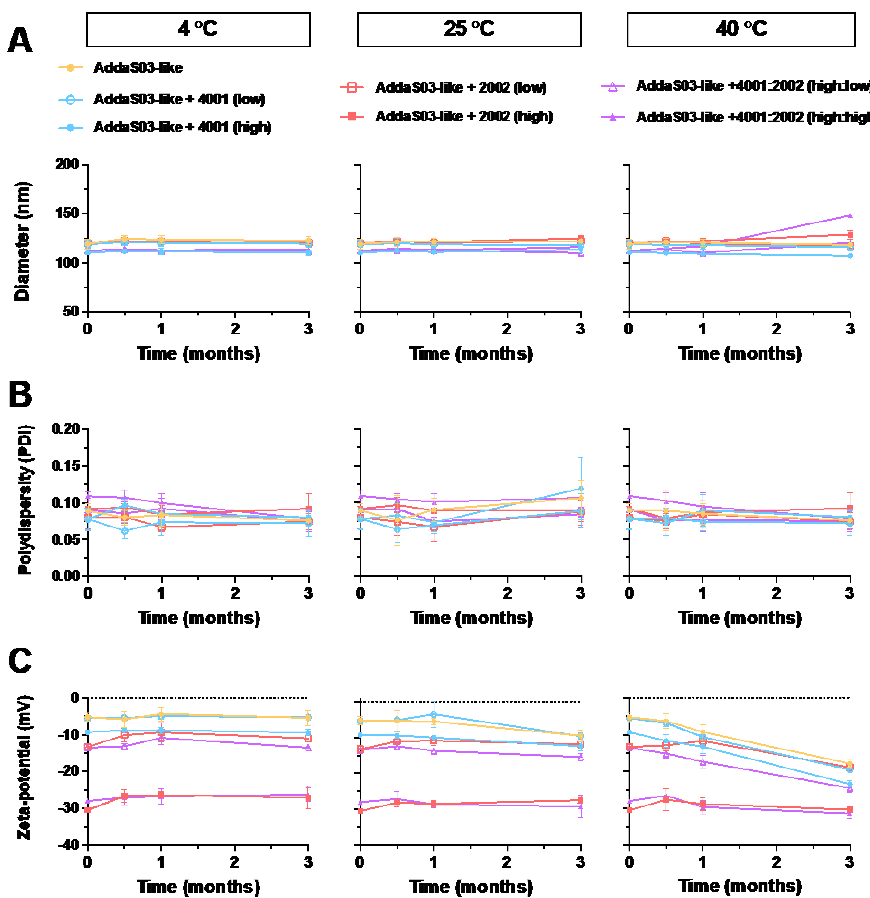
Figure 4. AddaS03-like emulsions maintained high colloidal stability at various temperatures with the addition of TLR4 and/or lipidated TLR7/8 agonists. An AddaS03-like emulsion was used to incorporate INI-4001 (TLR7/8 agonist) and/or INI-2002 (TLR4 agonist). Agonists were incorporated at low (0.175 mM) or high (1.75 mM) target concentrations, singly or coencapsulated. Dynamic light scattering was used to measure ( A ) hydrodynamic diameter (Z.Avg, nm), ( B ) polydispersity (PDI), and ( C ) zeta potential (mV) after storage at 4, 25, or 40 °C. Physical properties are given as mean ± SEM for replicate emulsions ( n = 4).